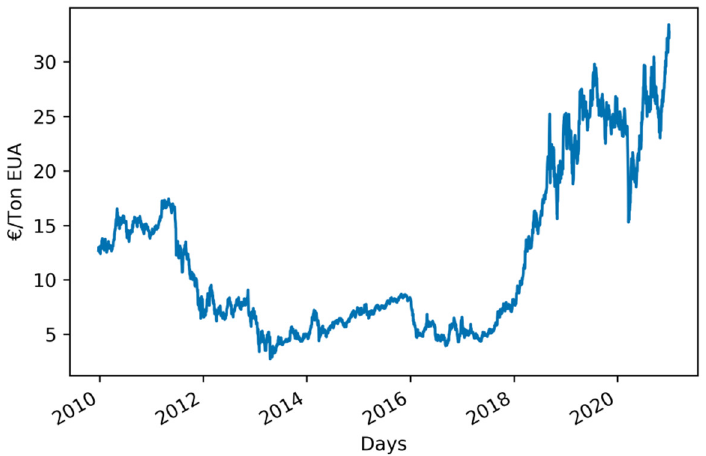
Figure 1. Daily spot prices of CO 2 .